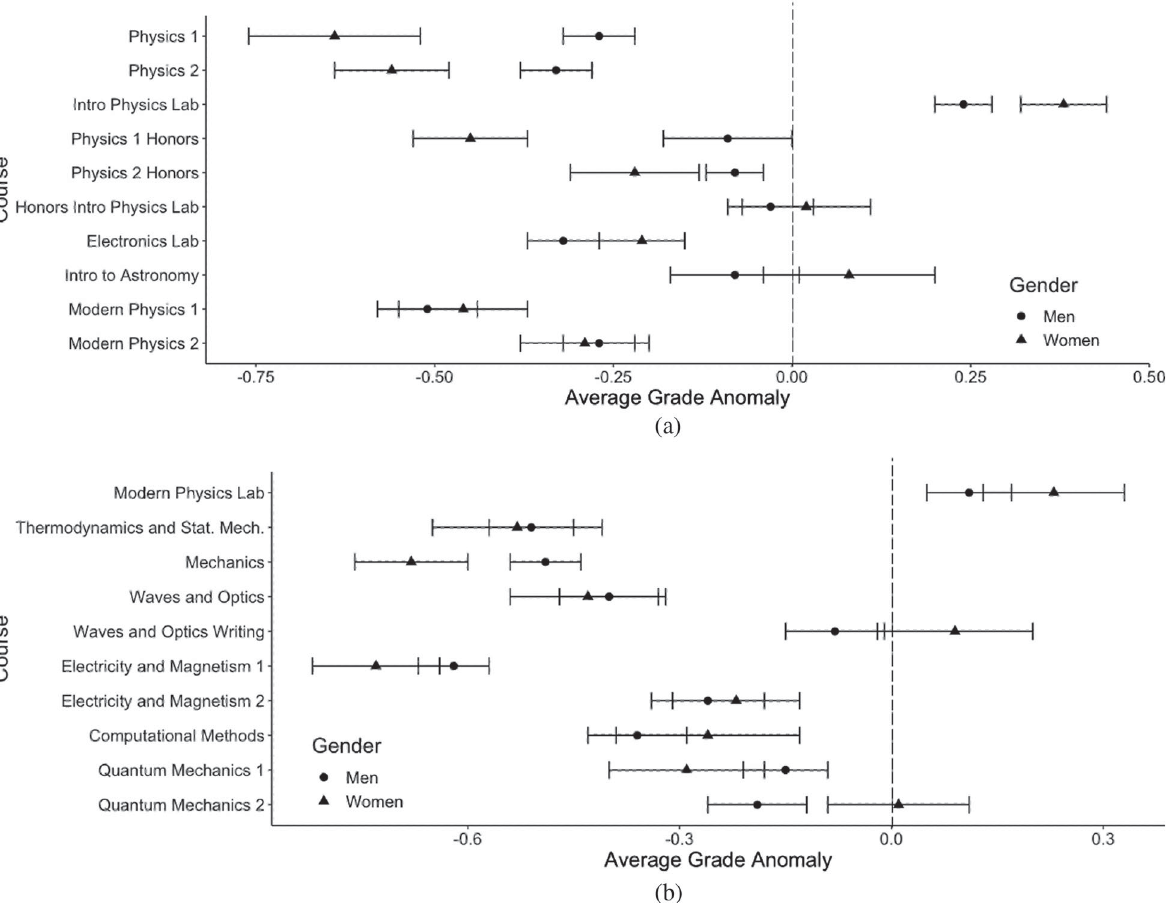
FIG. 1. Average grade anomalies of all students who declared a physics major by course, separated by gender. Ranges represent standard error of the mean. All courses are required except for Intro to Astronomy, Modern Physics 2, Electronics Lab, Modern Physics Lab, Electricity and Magnetism 2, Waves and Optics, Waves and Optics Writing, and Quantum Mechanics 2. The dashed line represents an average grade anomaly of 0. (a) Grade anomalies by course for students in their first and second year of university, separated by gender and (b) Grade anomalies by course for students in their first and second year of university, separated by